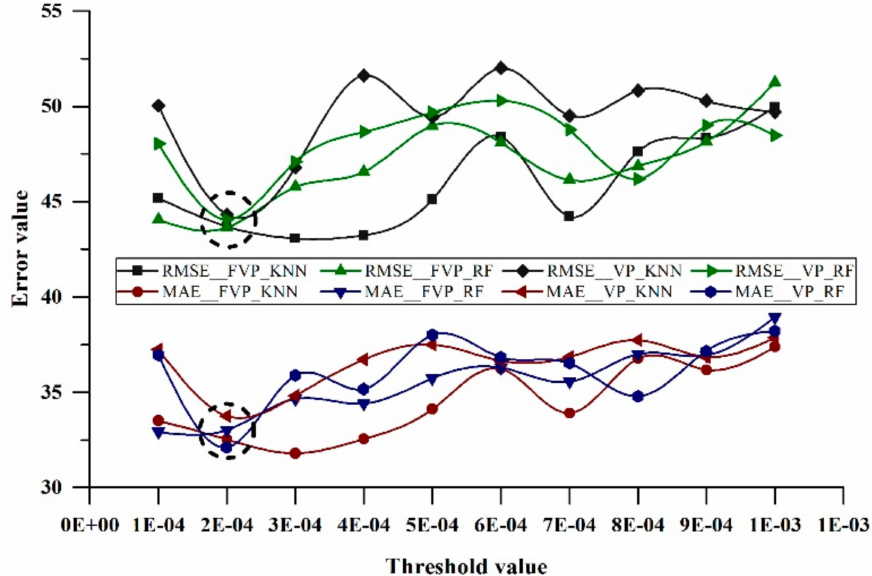
Figure 10. Root mean square error (RMSE) and mean absolute error (MAE) variations with di ff erent sample combinations and